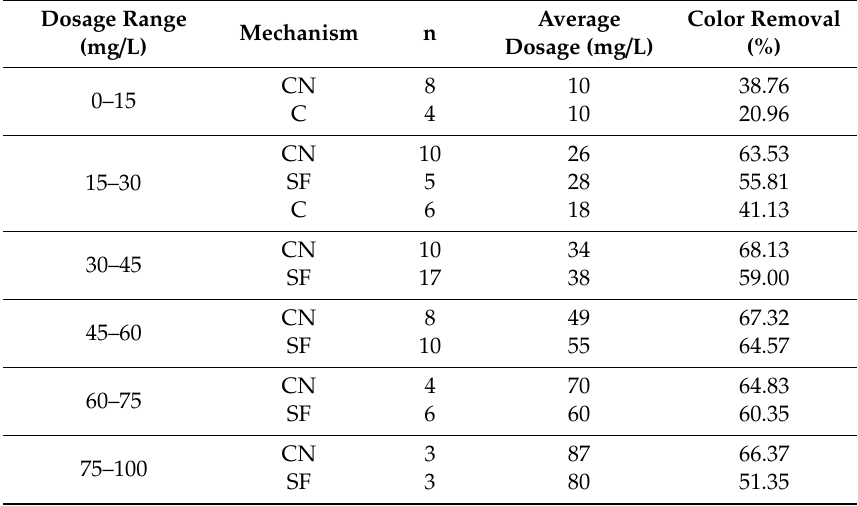
Table 7. Average apparent color removal rate for each aluminium sulfate dosage range and coagulation